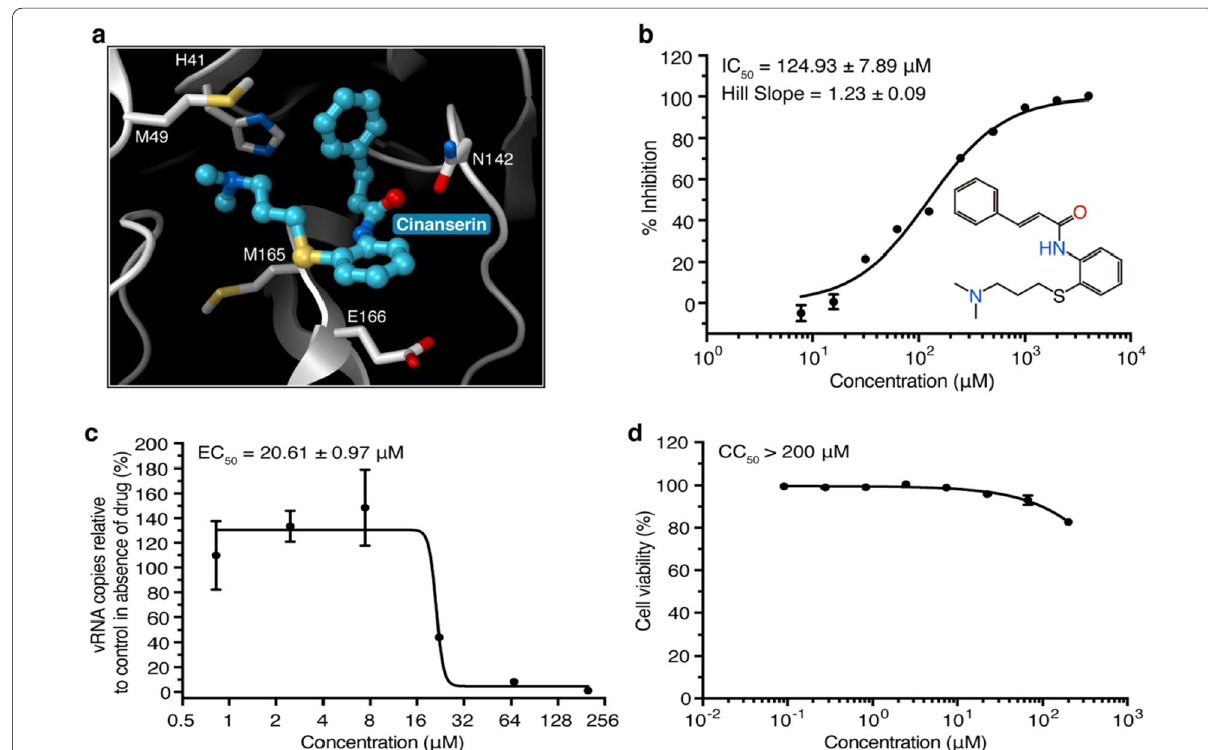
Fig. 6 a Cinanserin’s docking performance. SARS-CoV-2 M Pro ’s structure is depicted as a white cartoon, with cinanserin depicted as cyan balls and sticks, and residues anticipated to interact with cinanserin depicted as sticks. b Cinanserin’s suppressive action on M Pro . c qRT-PCR analysis